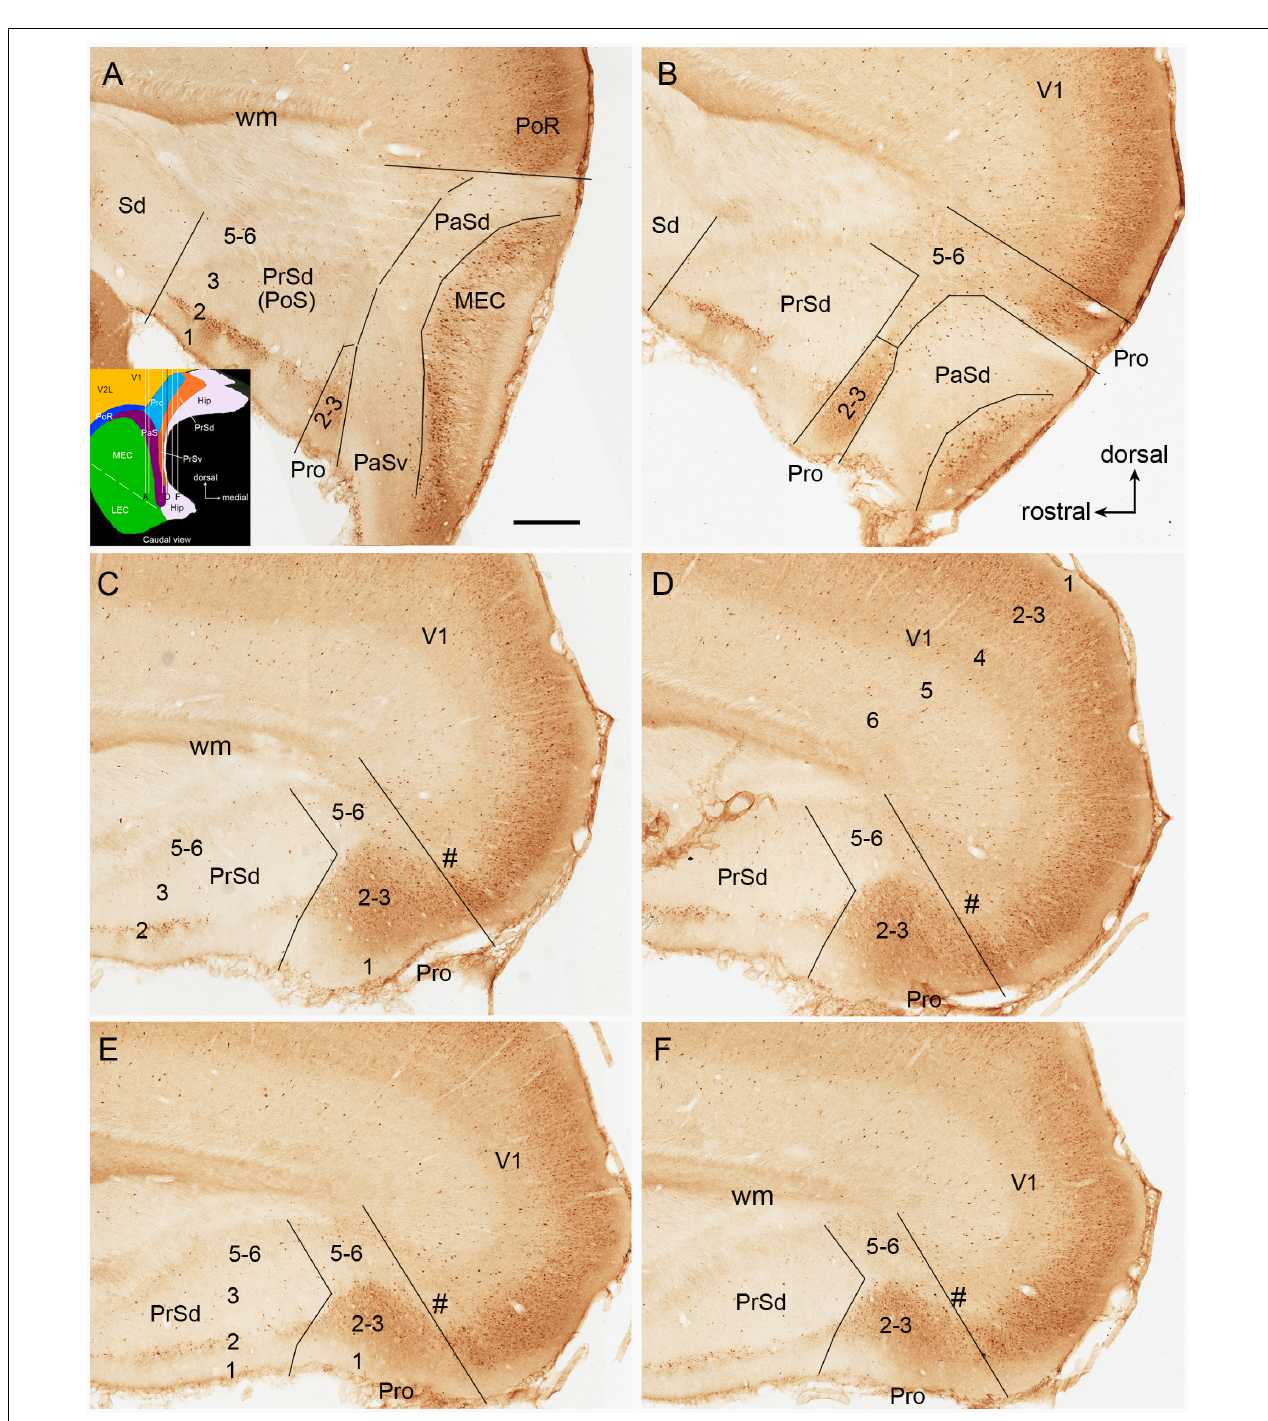
FIGURE 1 | Calbindin-D28k (CB) immunostaining in rat prostriata and adjoining regions. (A–F) Sequential sagittal sections from lateral (A) to medial (F) levels. The dorsal and rostral orientations are shown in (B) for all sagittal sections. The inset in (A) shows a schematic map of the region containing the prostriata (Pro) and adjoining areas (from caudal view) as well as the orientation of the sections shown in (A–F) (indicated by the vertical lines). Arabic numbers (1–6) indicate cortical layers. (A,B) Two sections at the lateral levels showing a small portion of layers 2–3 of the prostriata located between PrSd and parasubiculum (PaS). Note the overall faint CB labeling in the PaS. (C–F) Four sections at progressively more medial levels showing typical location of the prostriata. Most parts of the prostriata adjoin PrSd rostrally and the medial visual cortex (mainly V1) dorsocaudally. Note the narrow zone (marked by #) with weaker labeling at the junction between the prostriata and visual cortex. At all levels (A–F) , strong and weak CB labeling exists in layers 2–3 and 5–6 of the prostriata, respectively. Stronger CB labeling in layer 2 and weaker labeling in other layers of the dorsal presubiculum [PrSd; i.e., postsubiculum (PoS)] is also obvious. Sd, dorsal subiculum; PoR, postrhinal cortex; MEC, medial entorhinal cortex; V1, primary visual cortex; Hip, hippocampus; wm, white matter. Bar: 500 µ m in (A) for all panels.